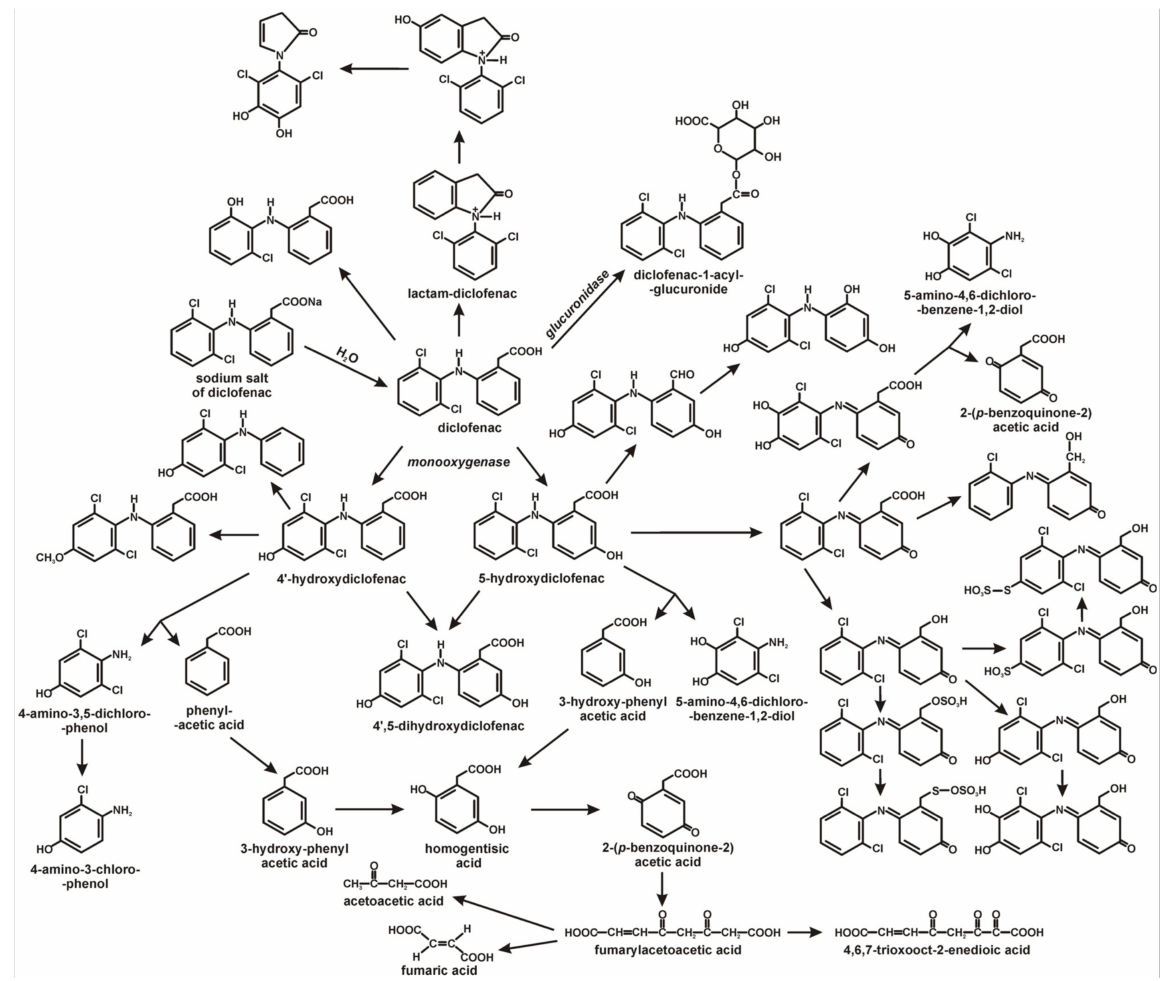
Figure 2. Diclofenac degradation by bacteria [9,10,55,56]. The adaptation mechanisms of Rhodococcus ruber IEGM 346 to high concentrations of this drug are altered ζ potential of bacterial cells, increased cell hydrophobicity and total cell lipid content, formation of multicellular conglomerates, and altered surface- to-volume ratio [54]. In addition, Moreira et al. [10] showed that the degradation of diclofenac by the Labrys portucalensis F11 strain took place through hydroxylation and the formation of benzoquinone imine as a key metabolite. The resulting product was further decarboxylated and hydroxylated. The stoichiometric release of chlorine and the lack of detected metabolites at the end of the experiments indicated complete degradation of the drug by the F11 strain. It was also the first time that a sulphation reaction was described during bacterial diclofenac decomposition, indicating the similarity of metabolites during bacterial diclofenac degradation to the conjugates which appeared during the Phase II detoxification diclofenac in mammals [8]. For another example, the similarities between the detoxification pathways of drugs in mammals and bacterial metabolism have also been shown by Murshid et al. [55]. They described Staphylococcus sp. and Alcaligenes sp. with the glucuronidase activity responsible for the conjugation of diclofenac with glucuronic acid to diclofenac 1-acyl-glucuronide